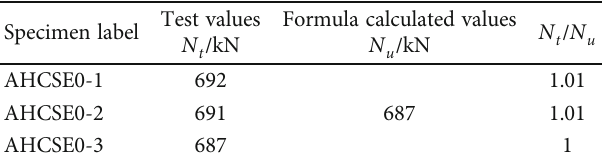
Table 6: Comparison of test values and theoretical formula calculation